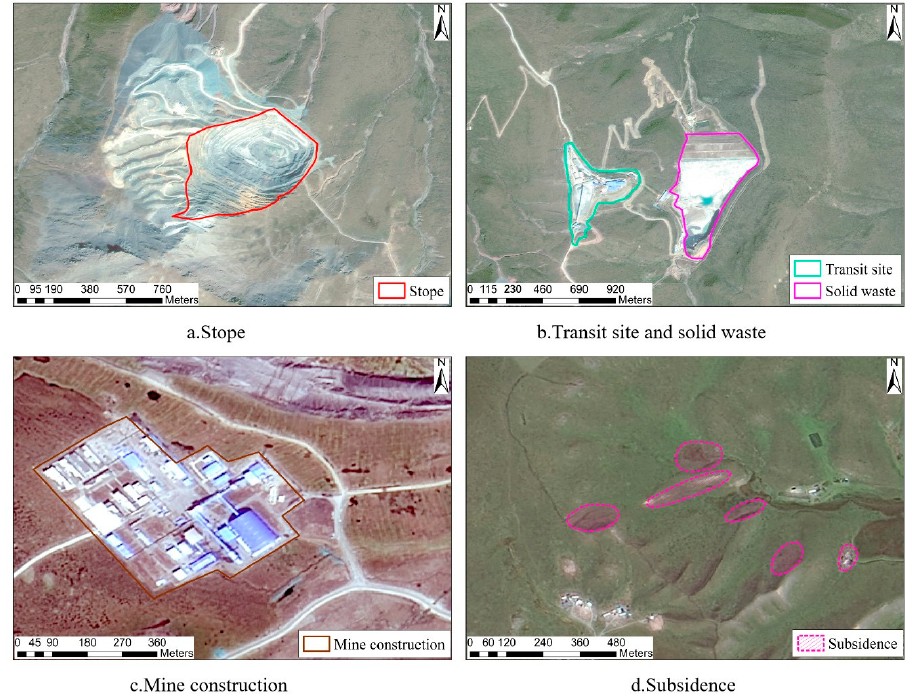
Figure 3. Mining remote sensing interpretation signs.